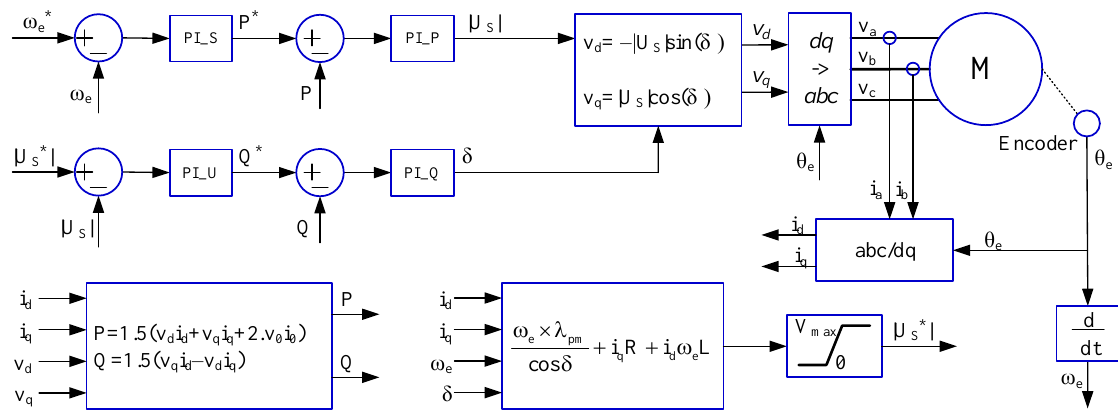
Figure 5. The PMSM speed control principle is based on the active and reactive power control of the inverters.